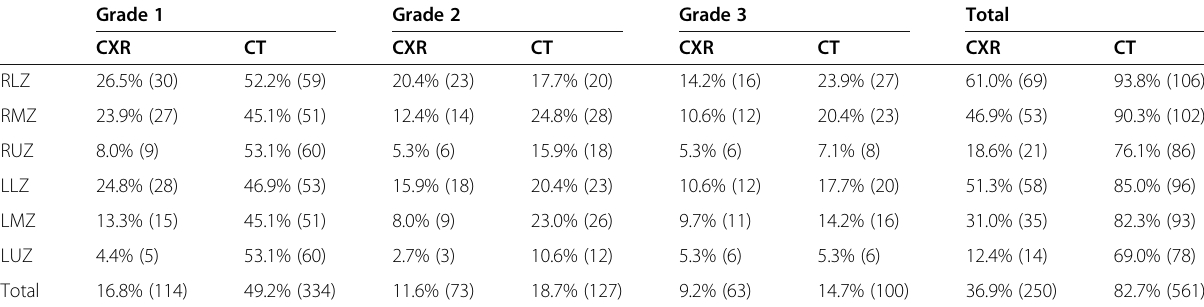
Table 2 Distribution of the lesions integrated into the grading system, number of involved zones ( n ), and percentages (%) ( n = 113, total zone =